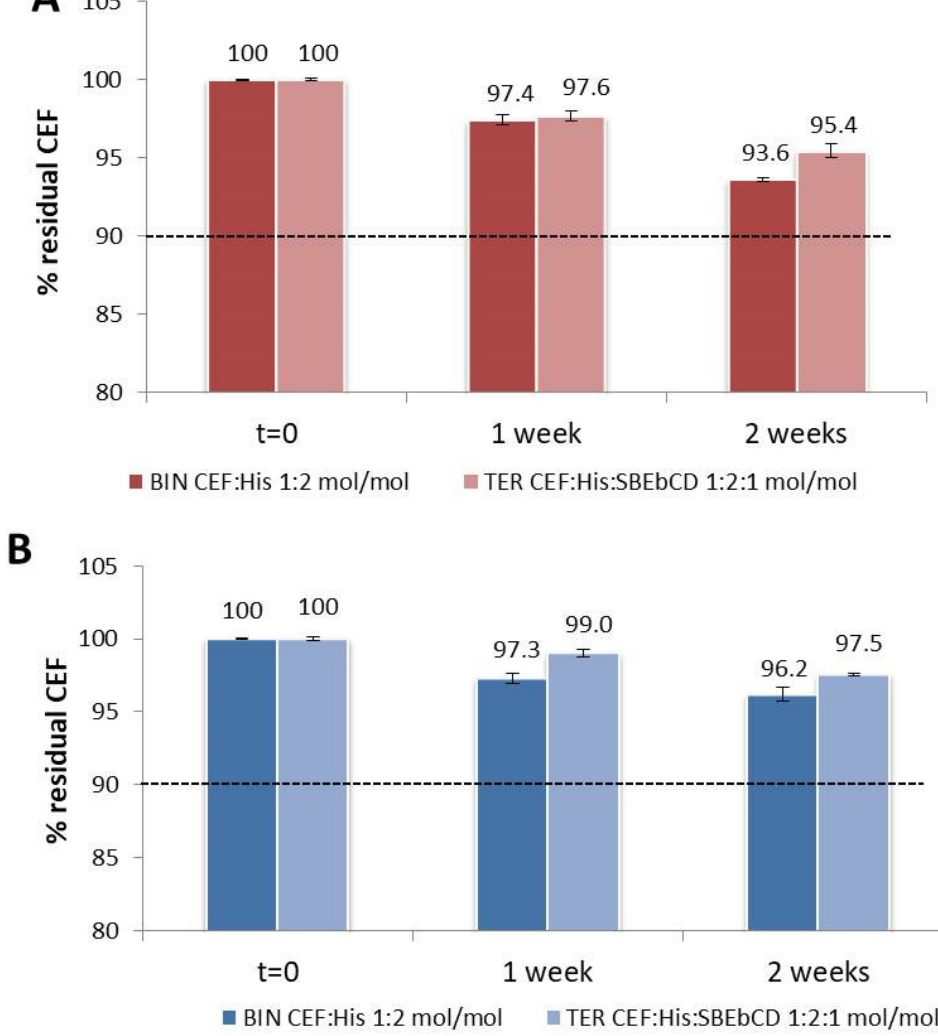
Figure 6. Stability studies on the binary CEF:His and CEF:His:SBE β CD ternary solutions stored at room temperature ( A ) or at 4 °C ( B ) in light-protected glass vials.